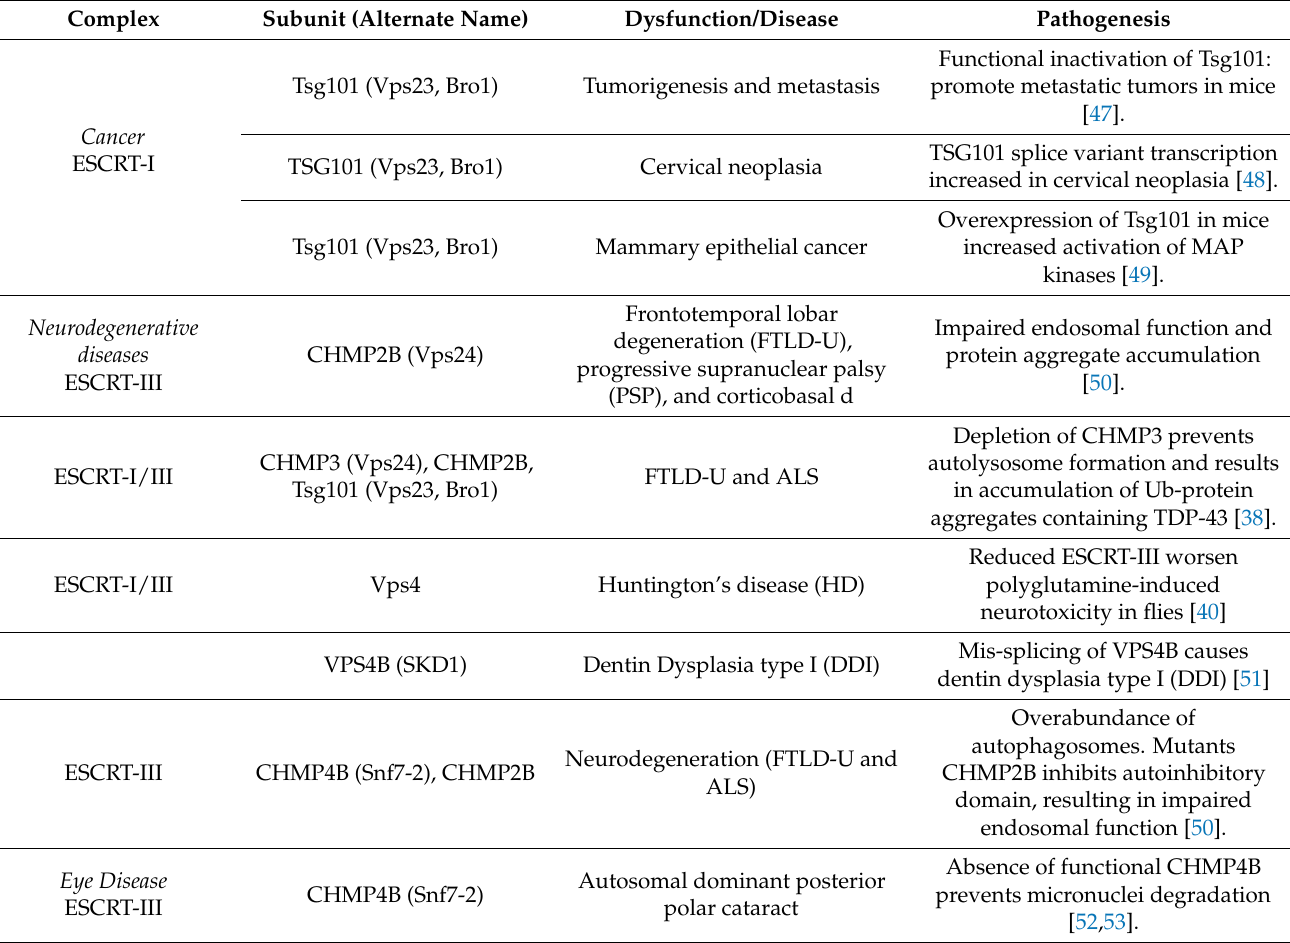
Table 1. A summary of disease and pathogenesis that results from impaired or dysfunctional ESCRT complexes. Impaired function of the ESCRT complexes has been associated with cancer, neurodegenerative diseases, and cataract